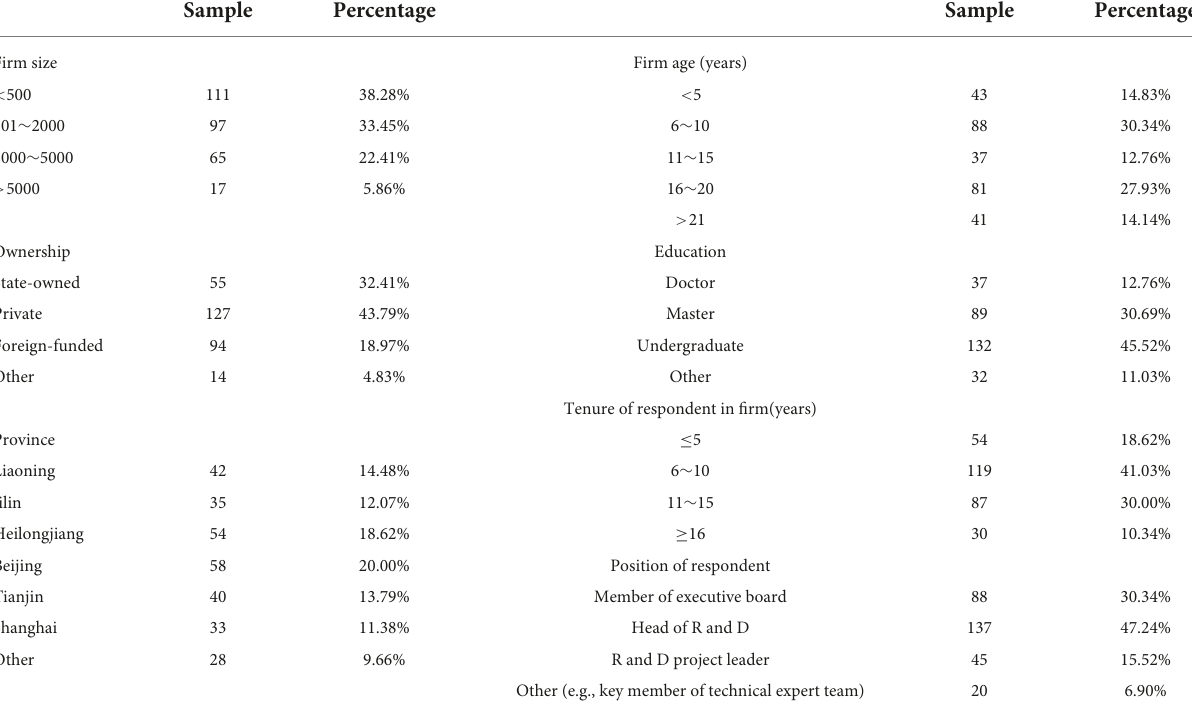
TABLE 1 Sample characteristics distribution of returned